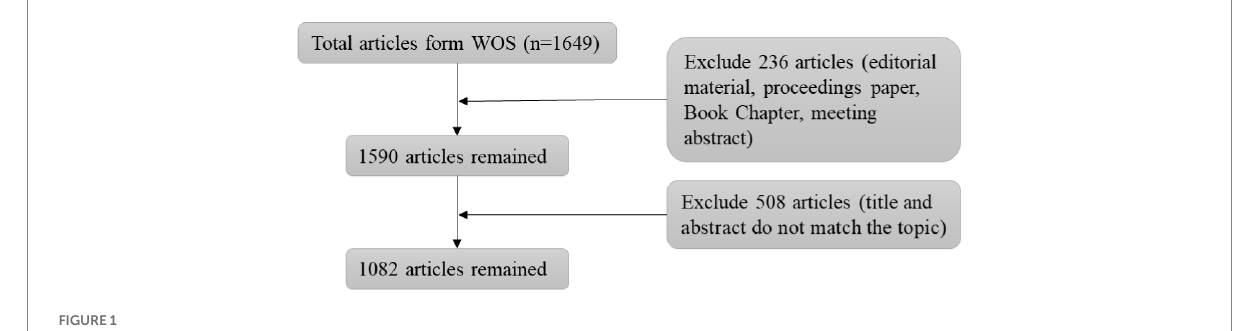
FIGURE 1 The steps of the inclusion